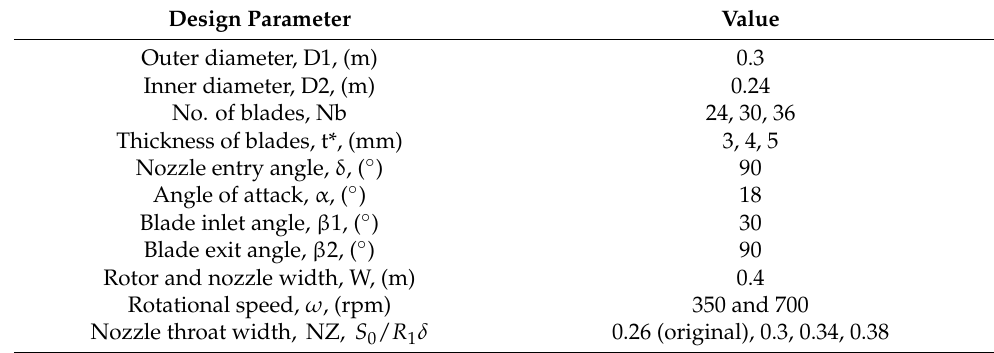
Figure 2. The grid and boundary condition of the numerical turbine model. 2.2. Data Analysis With a periodic bi-directional flow, non-steady performance of the turbine must be evaluated for each cycle as follows: